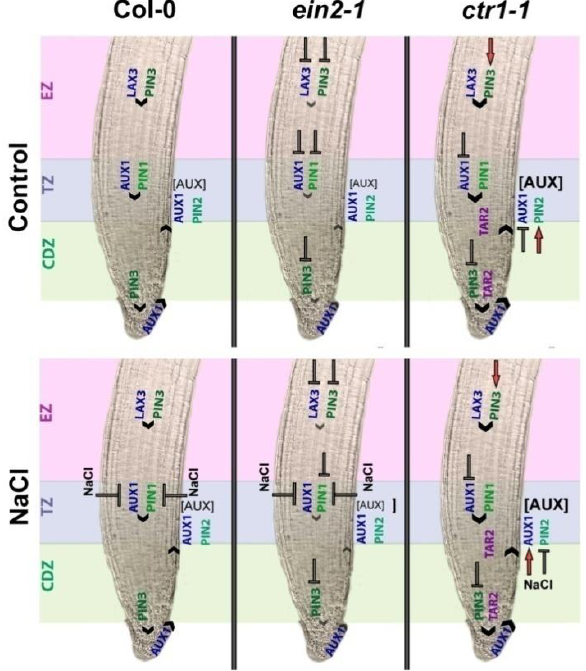
Figure 7. Model of root auxin homeostasis under salt stress in the Cell Division Zone (CDZ), Transzition Zone (TZ), and Elongation Zone (EZ) maintained by local auxin biosynthesis (TAR2) and polar transport (LAX3, AUX1, PIN1, PIN2, PIN3) in the wild type Col-0, ein2-1 and ctr1-1 Arabidopsis plants. The direction of auxin polar transport is depicted with black arrowheads. The T-shaped symbol marks inhibition and the red arrows designate activation compared to the wild type under the same conditions. The different font size of the letters in auxin concentration label [AUX] and the arrowheads reflects the variations between the wild type Col-0 and the mutant backgrounds.